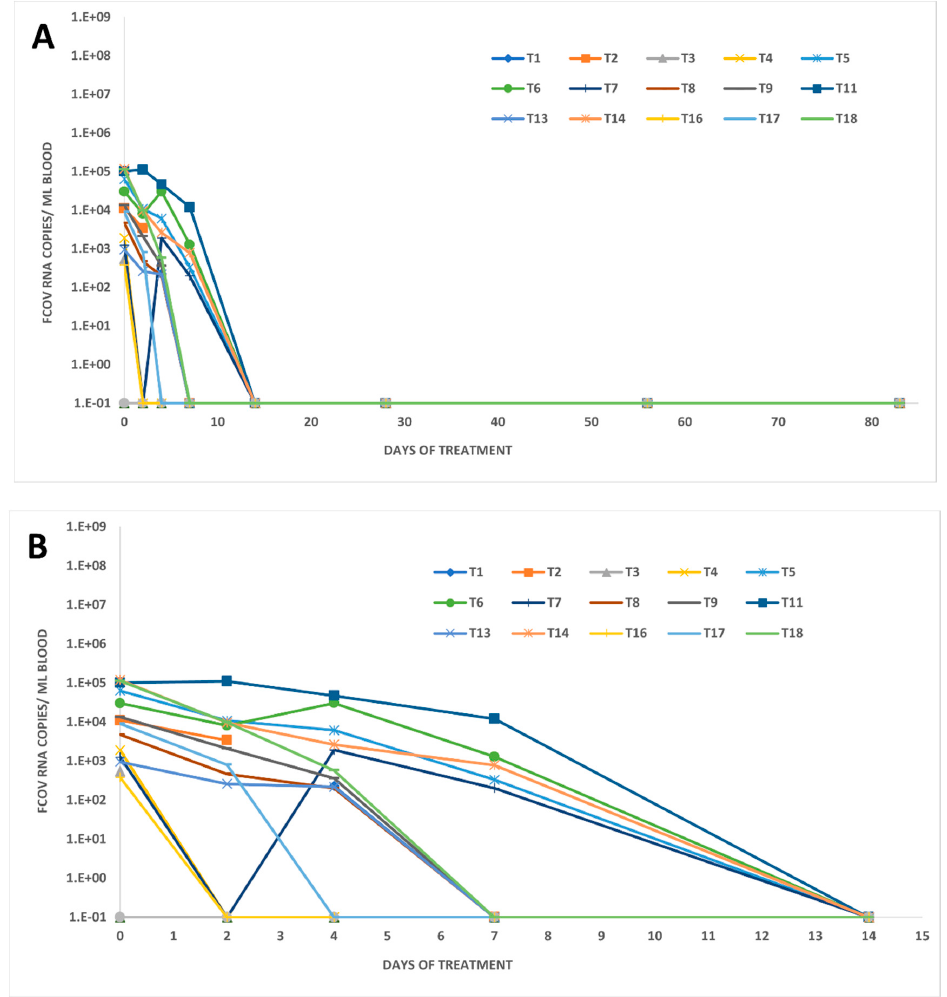
Figure 3. Viral RNA loads in blood samples of treated FIP cats. EDTA blood was collected ( A ): on days 0, 2, 4, 7, 14, 28, 56, and 83 and ( B ): on days 0, 2, 4, 7, and 14 for the determination of viral RNA loads. Loads were measured by feline coronavirus (FCoV) quantitative reverse transcription polymerase chain reaction (RT-qPCR) in cats. Values are given in copy numbers per mL blood. Sixteen of the eighteen treated FIP cats had effusion at treatment initiation (day 0), and all accessible effusions ( n = 12) tested RT-qPCR-positive at that time (Figure 1B). Viral RNA load in effusion decreased rapidly in most cats, while only two cats (T9 and T18) had increased loads one day after treatment initiation (Figures 1B and 4). After the initial increase, viral RNA loads in the effusion of cat T9 decreased from day 1 (684,114 cop- ies/mL) to the last effusion sampling on day 8 (691 copies/mL). The effusion of cat T18 was only accessible on day 0 and day 1. Therefore, it remains unknown if the viral RNA load would have decreased over time in this cat. Generally, viral RNA was detectable in all but three accessible effusion samples (from cat T6 on day 56 and cat T14 on days 14 and 56), and two of the three had a volume smaller than the 200 μ L usually used for TNA extraction. To increase the sensitivity of detection, these three samples were retested by RT-qPCR with 10 replicates, yielding negative re- sults.